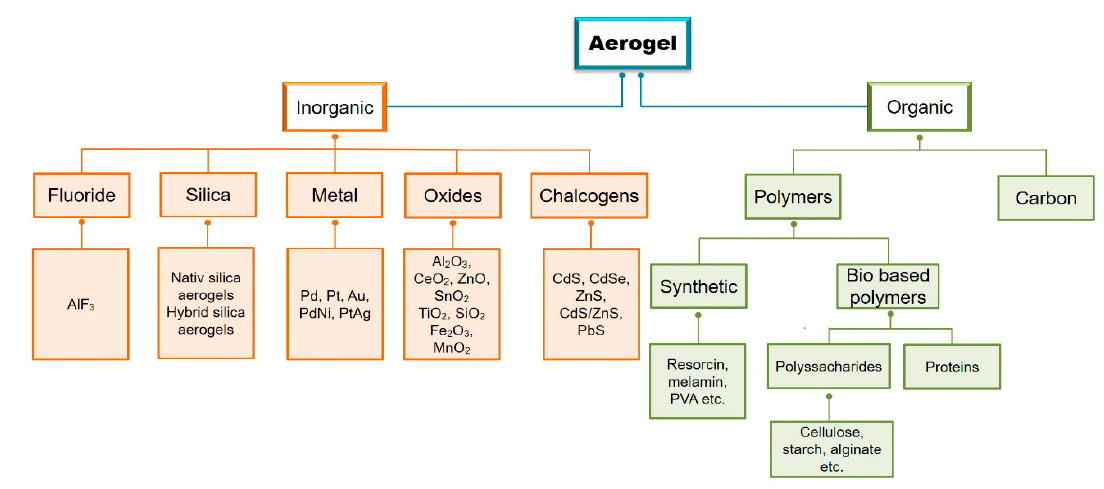
Figure 2. Classification of aerogels according to the nature of the materials used.